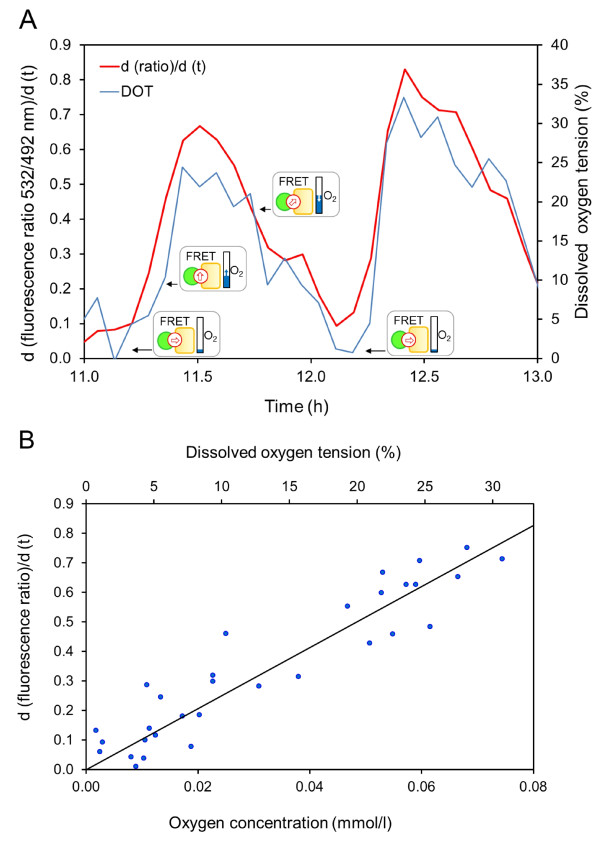
Calibration of FluBO for quantitative determination of intracellular oxygen. (A) During the logarithmic growth of E. coli cells, oxygen limitation was temporarily relieved twice by increasing the shaking frequency. The fitting curve of the time derivation of cyan-to-yellow fluorescence ratio (red) was drawn as described in the Methods. The pictograms symbolize the velocity of change of FRET ratio in dependence on cellular oxygen values: ⇨, no change; ⇧, fast increase; ⇗, slow increase. (B) The same data have been used to generate the calibration curve. In the used medium the value of 100% DOT corresponds to an oxygen concentration of 0.24 mmol/l at 30°C and an atmospheric pressure of 100 kPa. All parallel fermentation experiments in the microwells were performed in triplicates. The figures show a representative set of data.